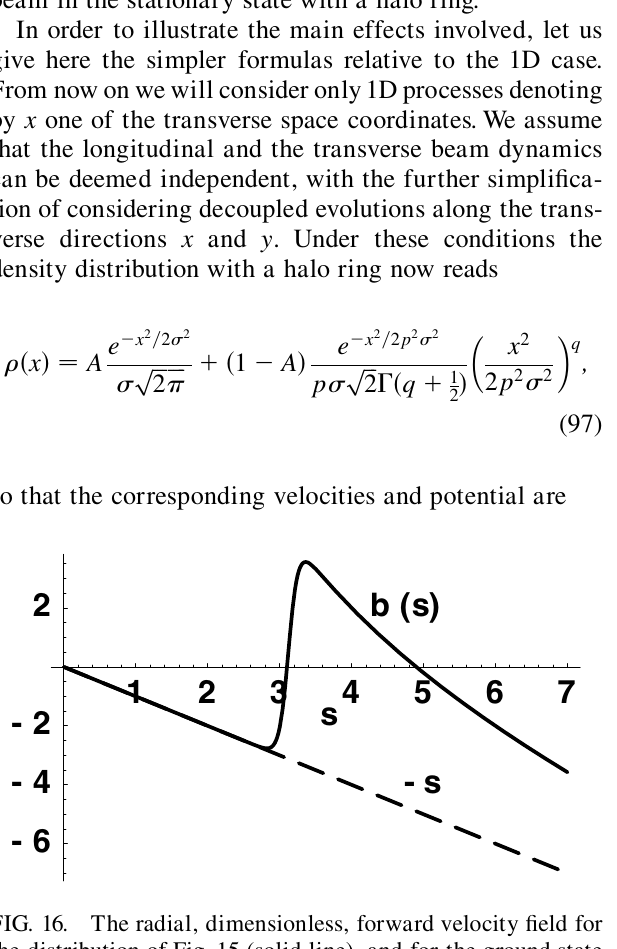
FIG. 18. Plot of the 1D density distribution (97) with a halo ring surrounding the beam